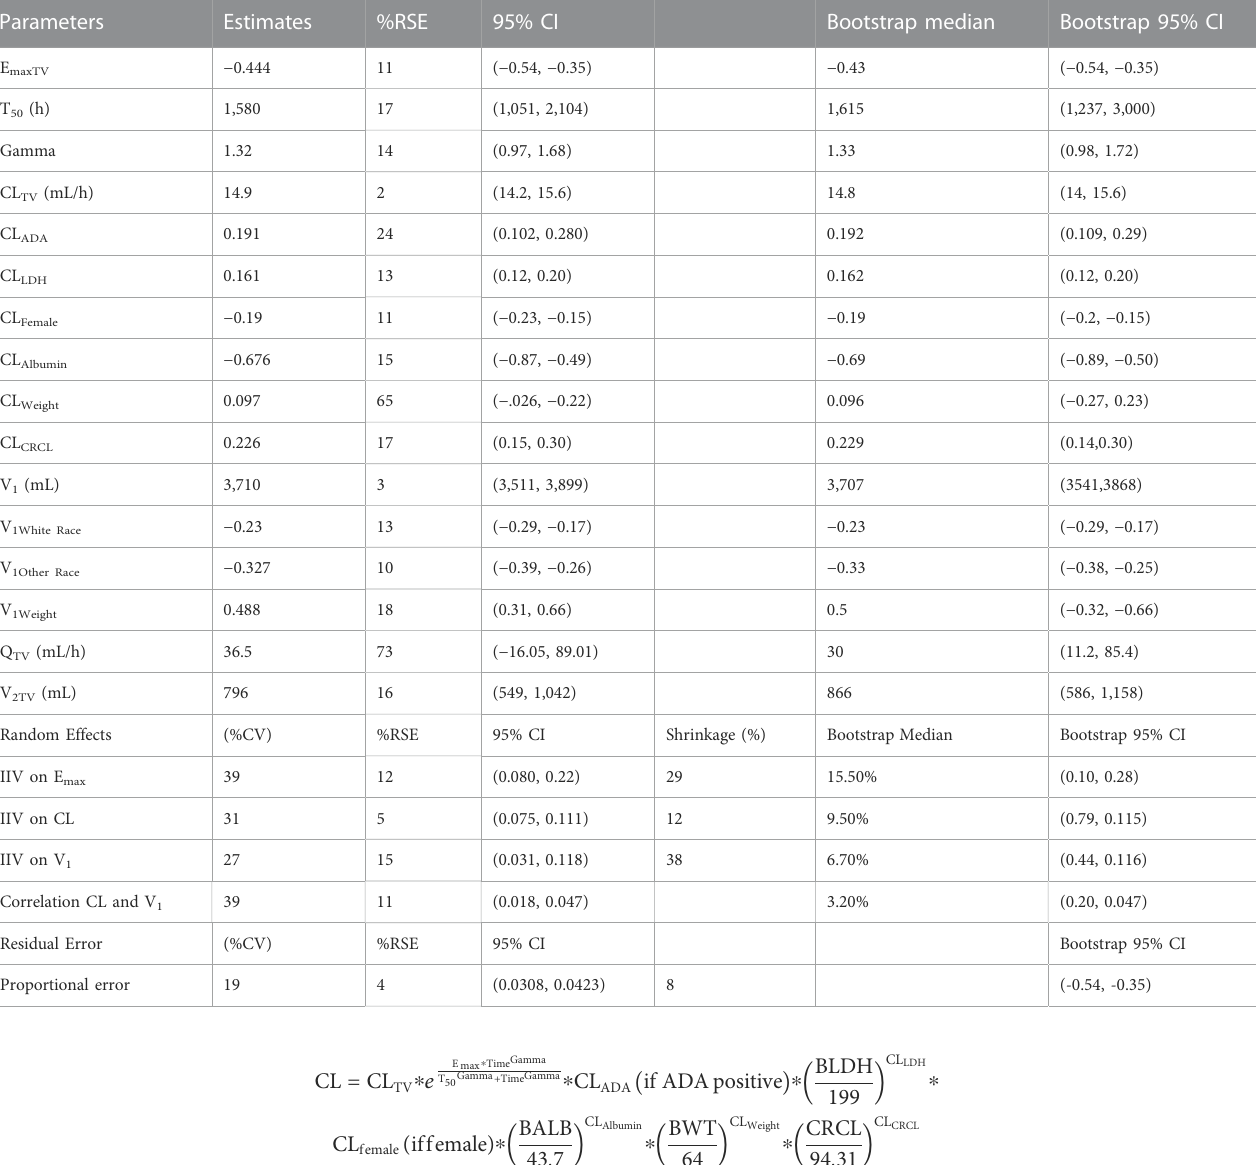
TABLE 1 Final PK model parameter along with 95% CIs obtained from bootstrapping runs.